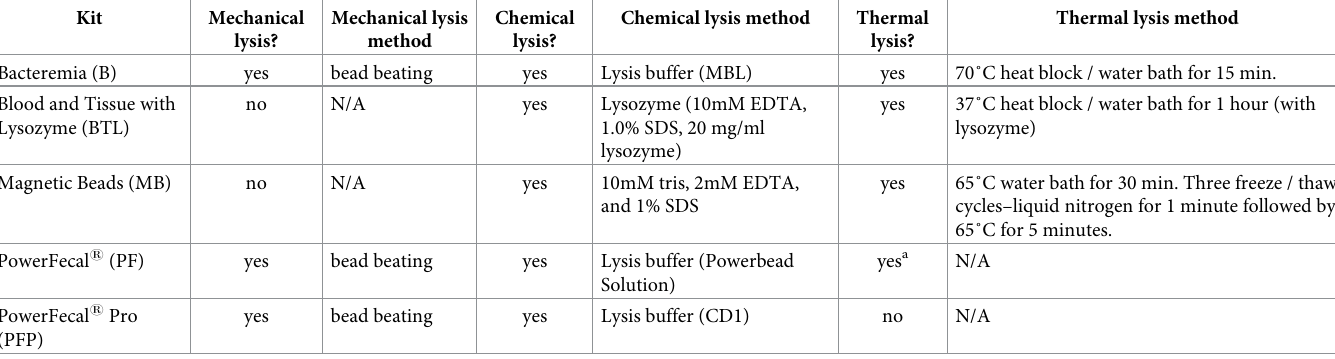
Table 1. Mechanical, chemical and thermal lysis properties of each extraction method.